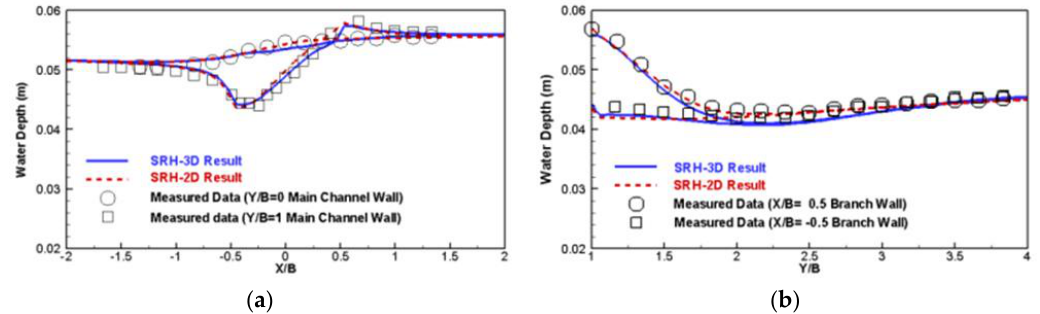
Fluids 2018 , 3 , x FOR PEER REVIEW Figure 2. Comparison of water elevation along both walls of the main channel ( a ) and the side channel ( b ).